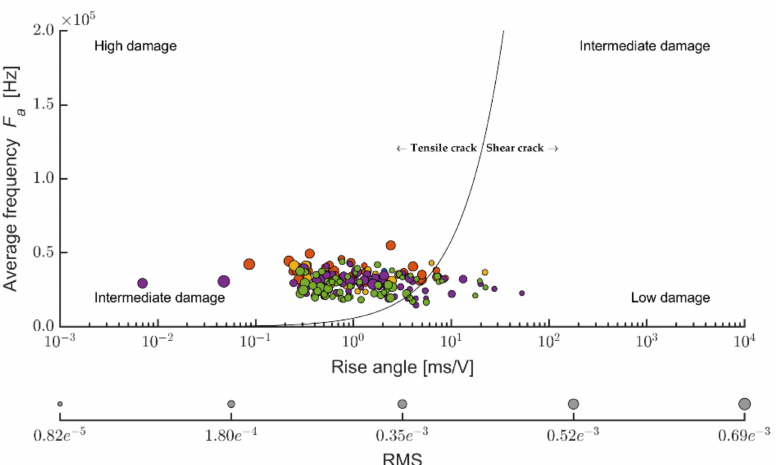
Figure 11. Scheme of AE evaluation interpretation using the calm ratio expressed by the average frequency and load ratio expressed using the RA